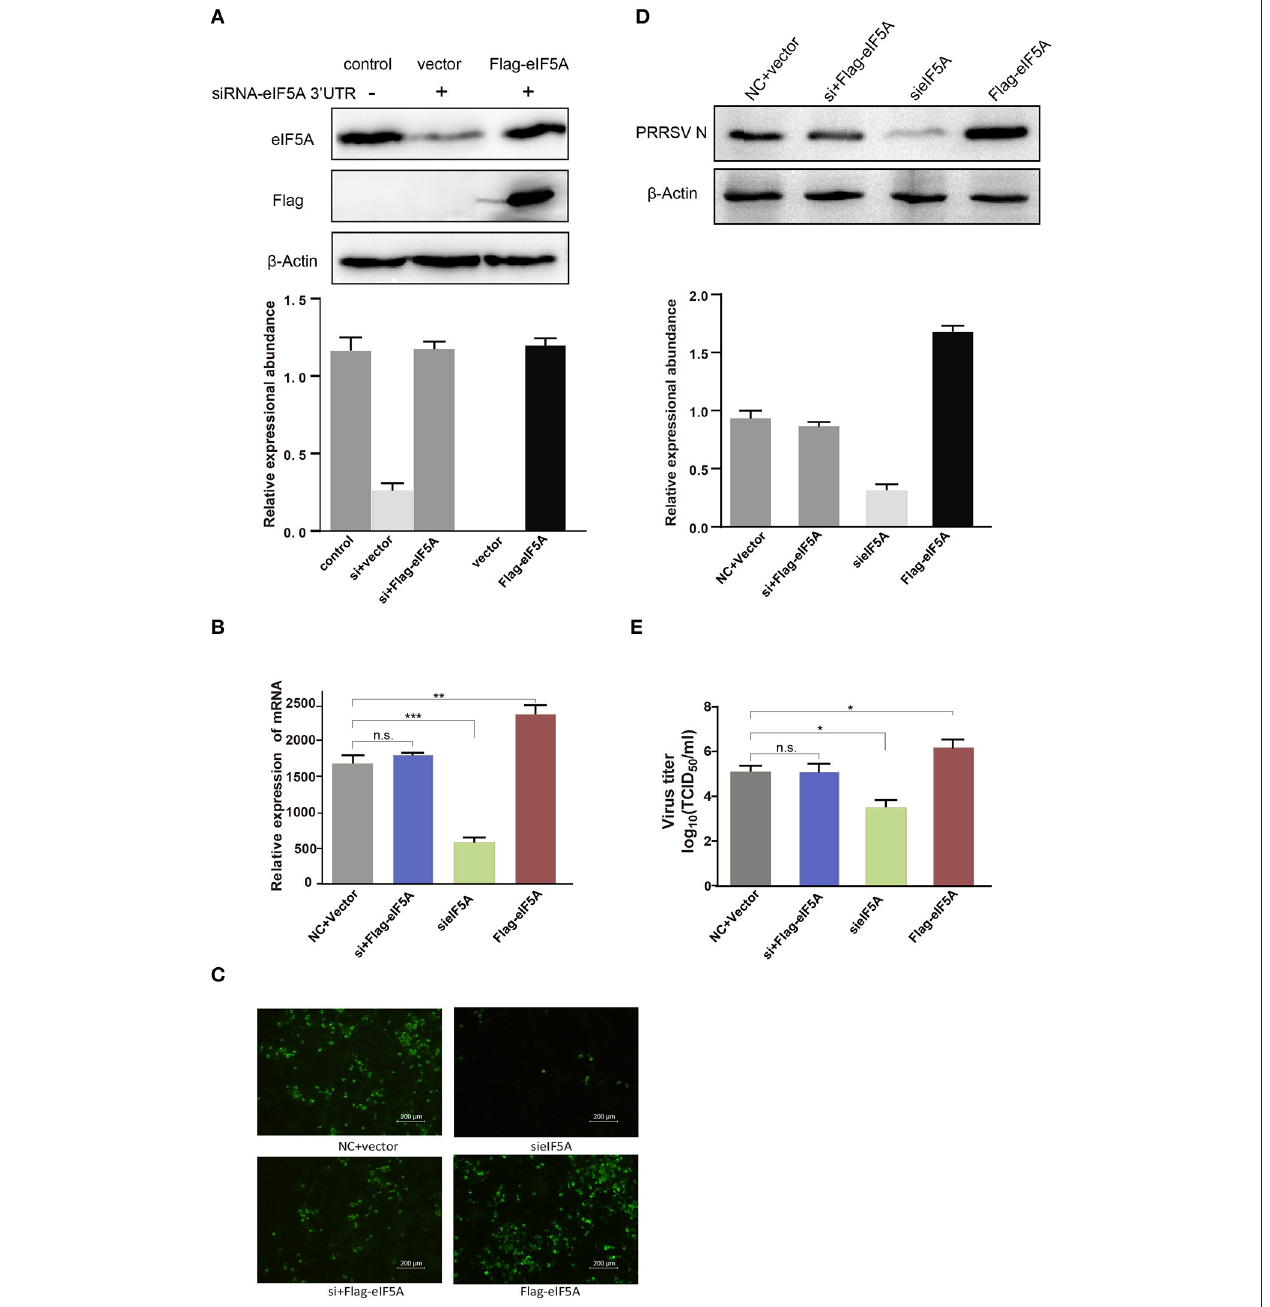
FIGURE 8 | Flag-tagged eIF5A rescued the inhibitory effect of eIF5A knockdown on PRRSV propagation. (A) WB analysis of endogenous eIF5A in CRL-2843-CD163 cells and recombinant Flag-tagged eIF5A in CRL-2843-CD163 cells with eIF5A knockdown. Endogenous eIF5A was knocked down by siRNA targeting of the eIF5A 3 ′ UTR in CRL-2843-CD163 cells. HP-PRRSV HN07-1 (MOI = 0.1) was added to endogenous eIF5A knockdown CRL-2843-CD163 cells with recombinant Flag-tagged eIF5A overexpression. PRRSV propagation was validated by (B) RT-PCR, (C) IFA and (D) WB, (E) Virus titers were also determined. Each experiment was performed three times independently and all had similar results. * P < 0.05; ** P < 0.01; *** P < 0.001; ns, not significant. expression levels of hnRNPA1 and eIF4G1 proteins were decreased in the PEDV YN144-infected group, suggesting that both proteins might be connected to PEDV YN144